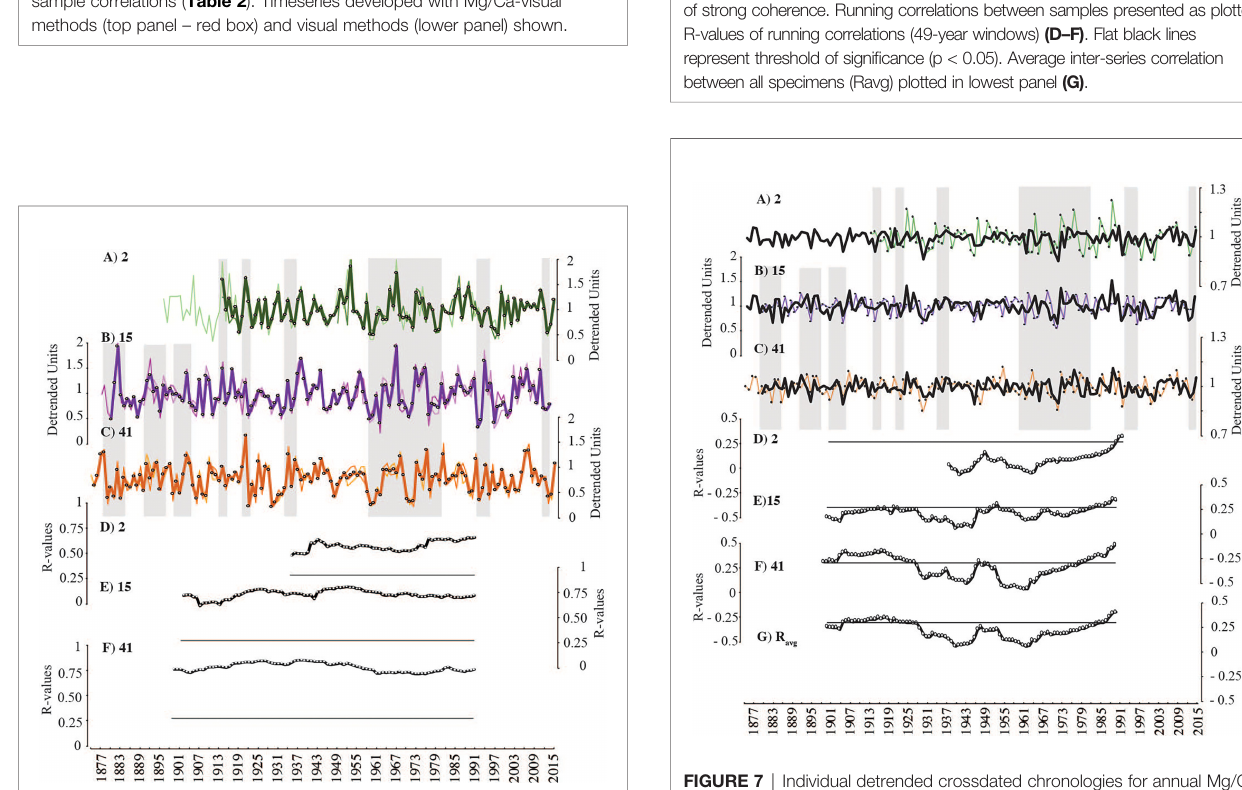
FIGURE 7 | Individual detrended crossdated chronologies for annual Mg/Ca maxima (thin coloured lines A – C ) compared to the averaged timeseries of the other two crossdated specimens (i.e., two-sample master chronology: black). Grey vertical bars show highlighted periods of synchrony. Running correlations between samples presented as plotted R-values of running correlations (49-year windows) (D – F) . Flat black lines represent threshold of signi fi cance (p < 0.05). Average inter-series correlation between all specimens (R avg ) plotted in lowest panel (G)